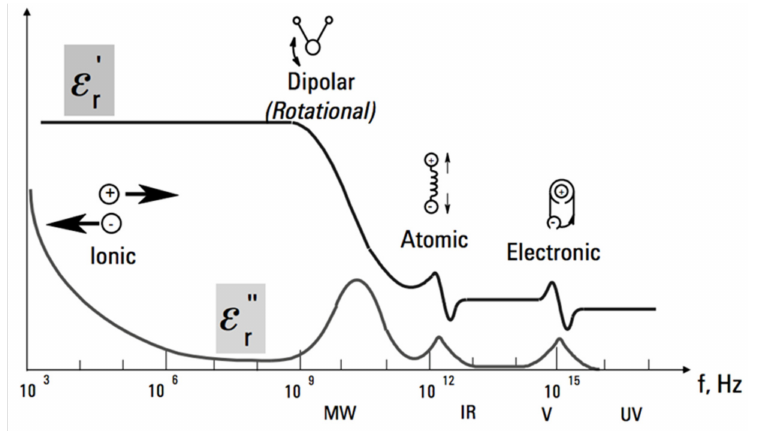
Figure 1. Frequency dependence of complex permittivity ( ε ’, ε ”)